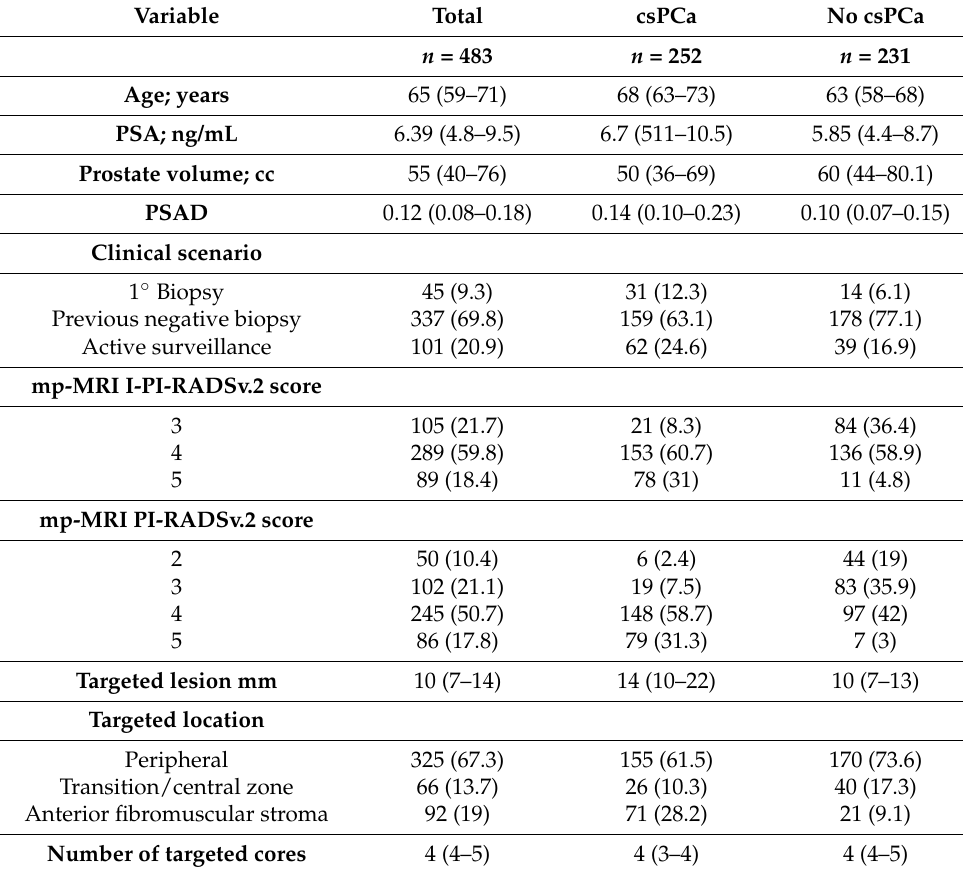
Table 1. Characteristics and description of the cohort according to csPCa